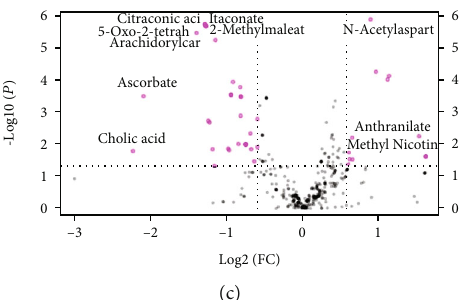
Figure 2: Analysis of the di ff erent metabolites. (a) Heatmap shows the di ff erence in the top 50 metabolites between the healthy group and the AIS group. (b) Fold change diagram shows the fold change of di ff erent metabolites. (c) Volcano plot shows the changes in di ff erent metabolites.